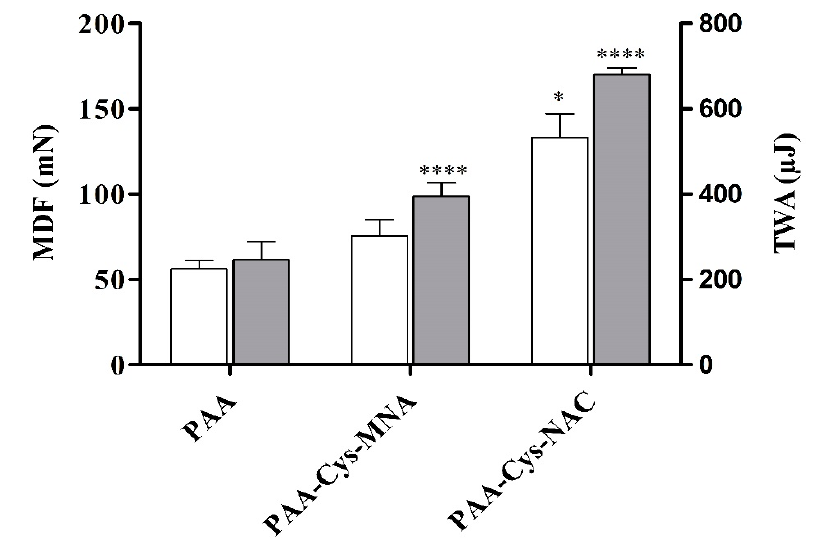
Figure 10. Tensile studies on porcine small intestinal mucosa. The MDF and TWA of the test disks of unmodified PAA and S-protected thiolated PAA conjugates on intestinal mucosa were measured with a texture analyzer. White bars depict MDF and light gray bars represent TWA. The data are shown as mean ± SD (n = 3).